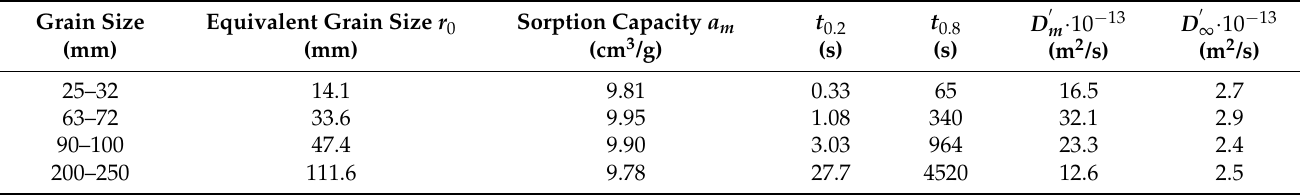
Table 1. Measurement results of CO 2 desorption from coal of different fractions obtained after initial saturation at a pressure of 0.25 MPa and emission to the